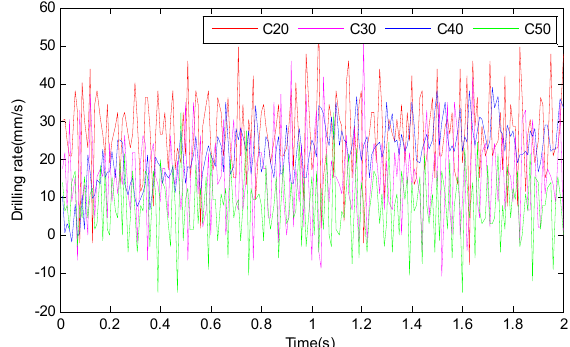
Figure 8. Drilling speed chart for bit drilling.